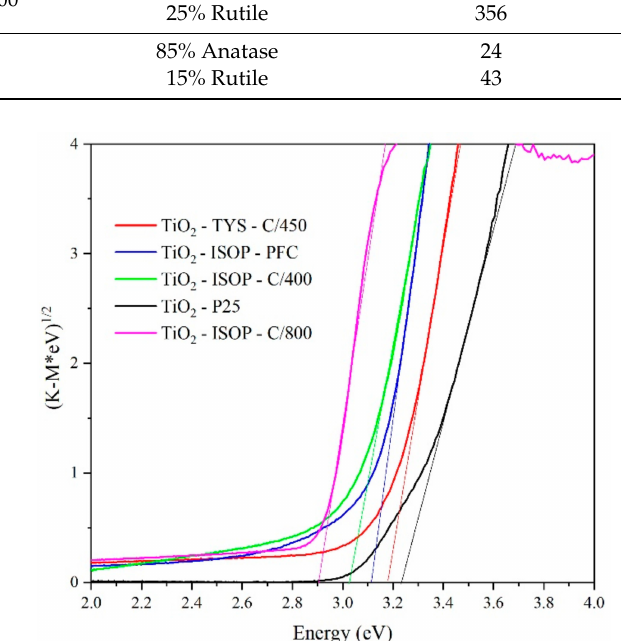
Figure 3. Tauc plots of investigated TiO 2